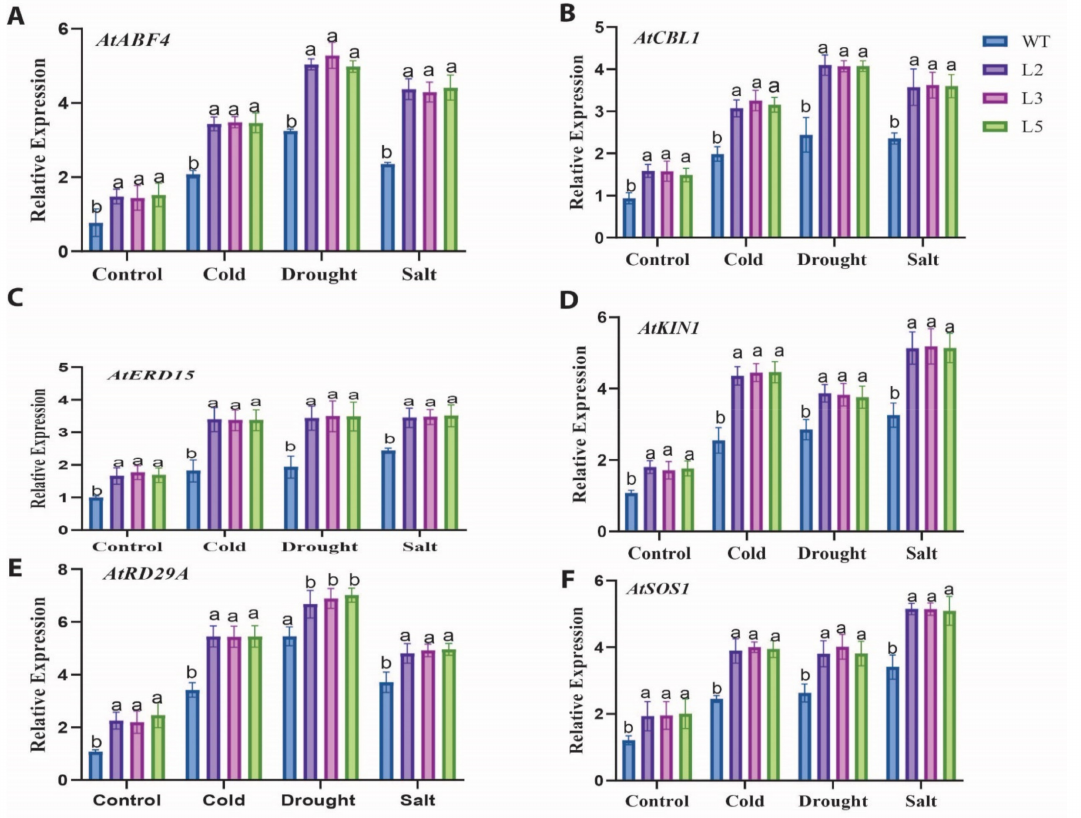
Figure 7. Expression profiles of abiotic stress-responsive genes. ( A ) AtABF4 , ( B ) AtCBL1 , ( C ) AtERD15, ( D ) AtKIN1, ( E